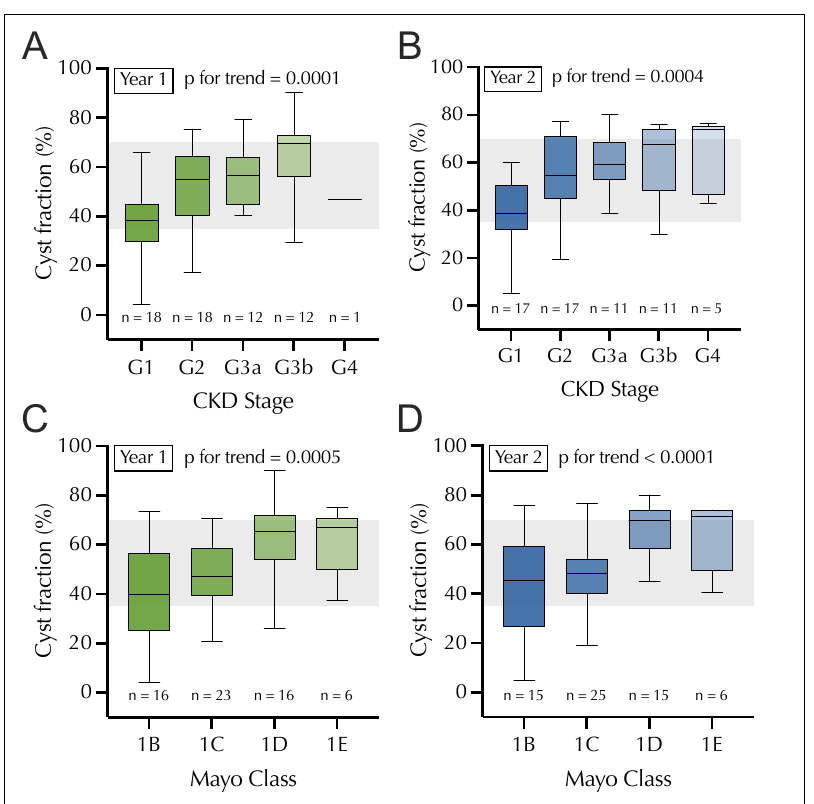
Figure 3. Cyst fraction (%) according to CKD stage ( A , B ) and Mayo class ( C , D ) among ADPKD patients for year 1 ( A , C ) and year 2 ( B , D ). CKD, chronic kidney disease. The grey area in ( A – D ) depicts the medium cyst fraction (35–70%).